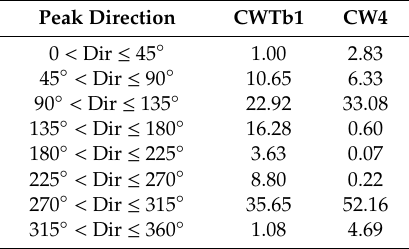
Table 3. Occurrence of peak wave direction from each station. Occurrence is presented in percentages and directions represent the direction the waves are coming from.